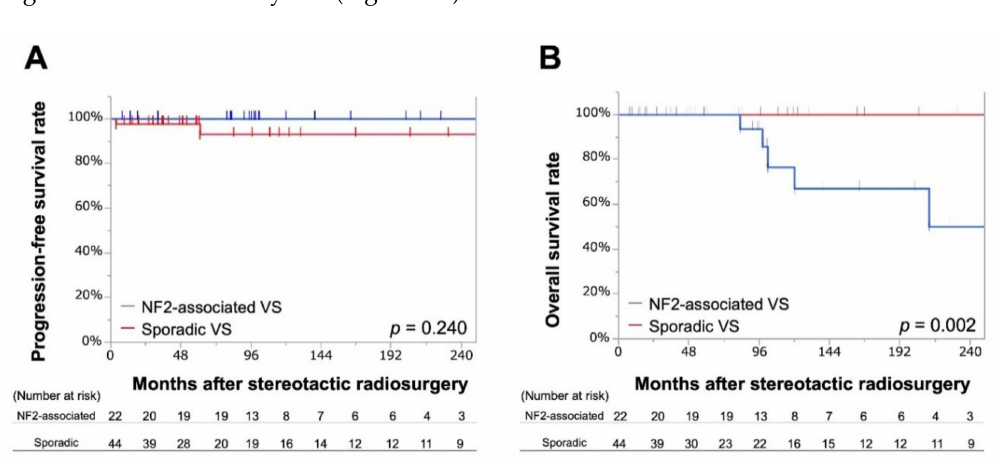
Figure 2. Kaplan-Meier curve for progression-free survival rate ( A ) and overall survival rate ( B ) among the propensity score-matched cohort comparing neurofibromatosis type 2-associated vestibular schwannoma with sporadic vestibular schwannoma. NF2 = neurofibromatosis type 2; OS = overall survival rate; PFR = progression-free rate; VS = vestibular